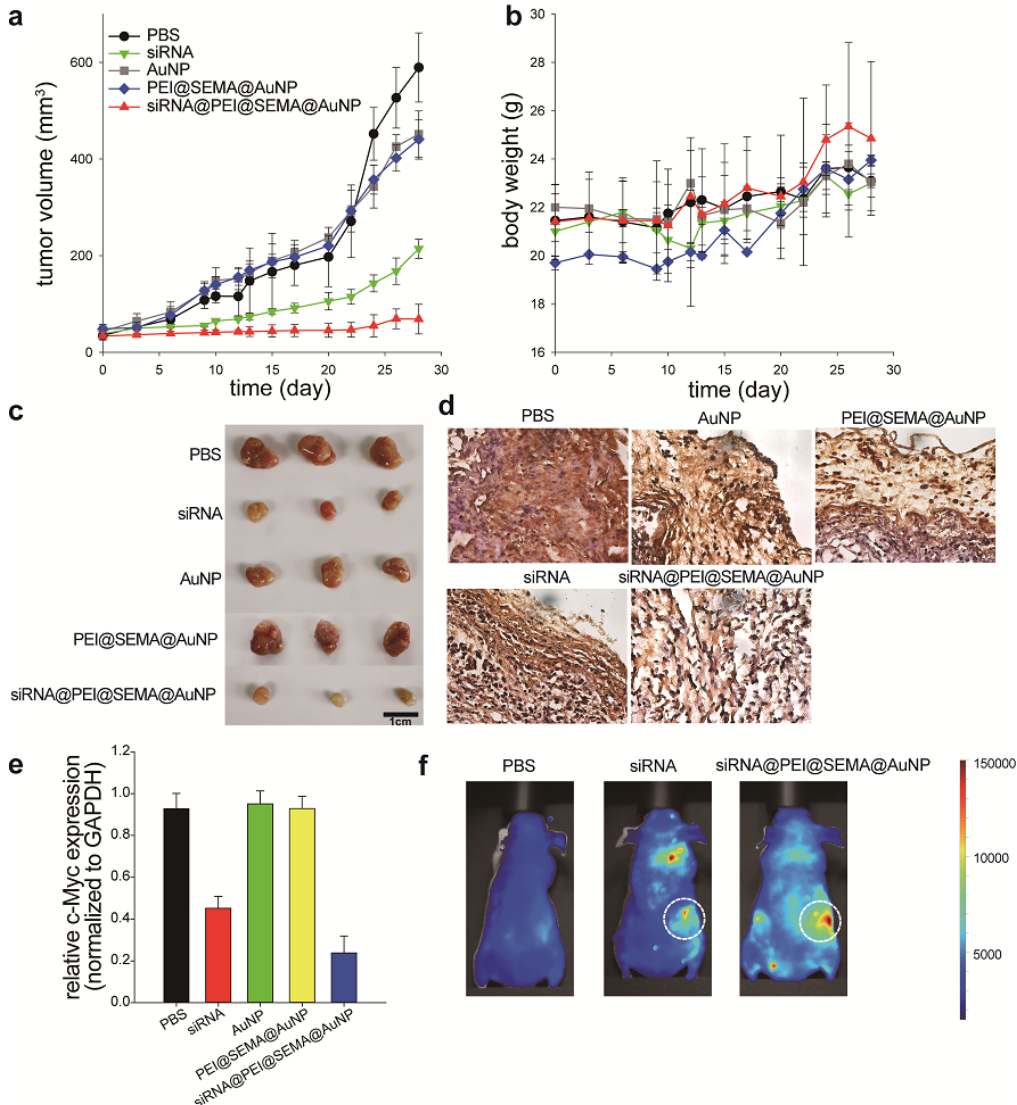
Figure 6. Animal study to determine in vivo anti-cancer effect of siRNA loaded AuNP to tumor-bearing mice. Intravenous injections were performed to the tail vein five times every 3 days. ( a ) Changes of tumor volume and ( b ) body weights were monitored for 28 days. The arrows at x-axis indicate the time of injection. ( c ) Tumors were harvested and compared for the size after 28 days. ( d ) Tumor tissues were visualized by immunohistochemical staining with anti c-Myc antibody (brown) and counter-staining with hematoxylin (purple). ( e ) Relative c-Myc gene suppression levels of the tumor tissues were determined by qRT-PCR. ( f ) Fluorescence imaging of live animals. Phosphate-bu ff ered saline (PBS) and Alexa Fluor 647-labeled siRNA (AF647-siRNA) and AF647-siRNA@PEI@SEMA@AuNPs were injected, and the anesthetized animals were imaged after 12 h.